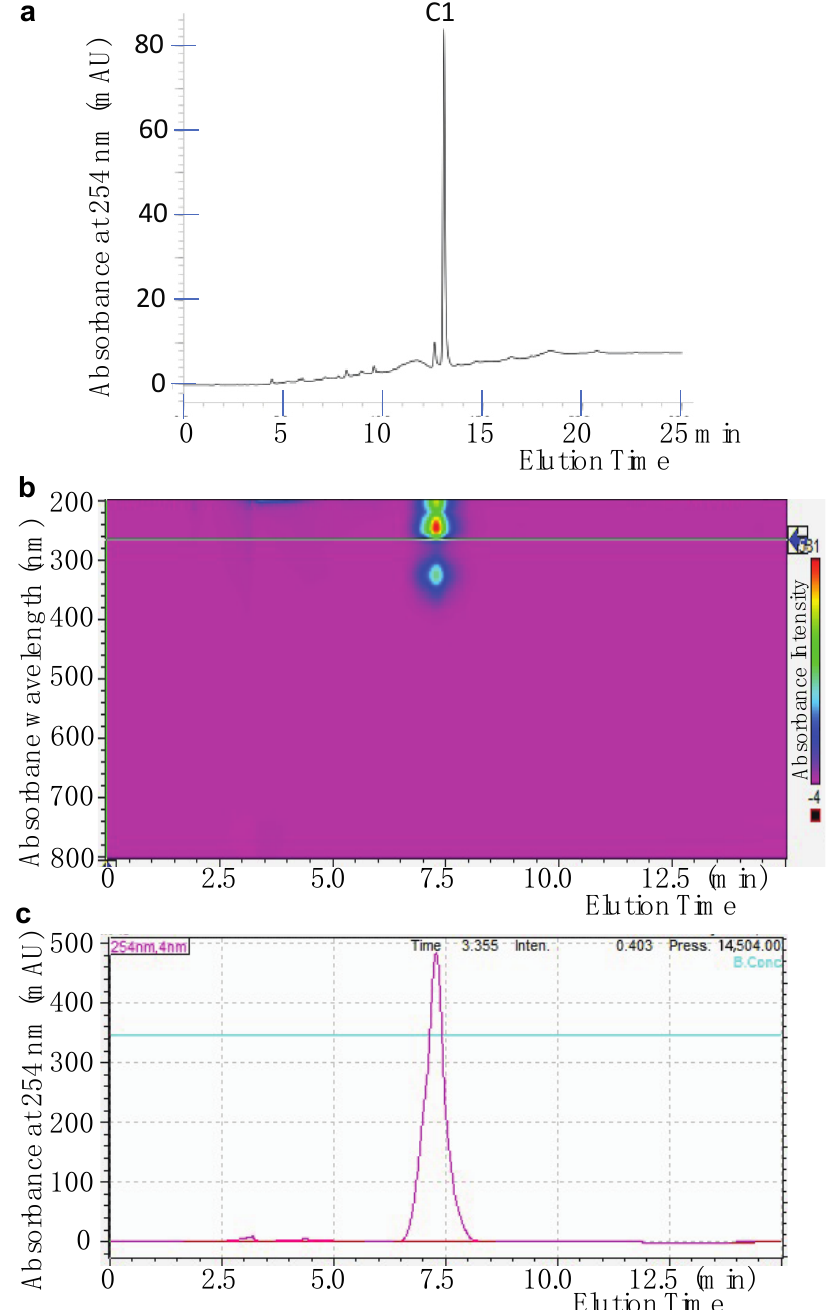
Figure 4. Separation of an active compound by HPLC. ( a ) HPLC profile of active fraction SF-1 containing active compound C1. ( b ) Analysis of purity of C1 using HPLC showed one major peak at 7.4 min by A 200–800 . ( c ) A 254 profile of elution from HPLC.